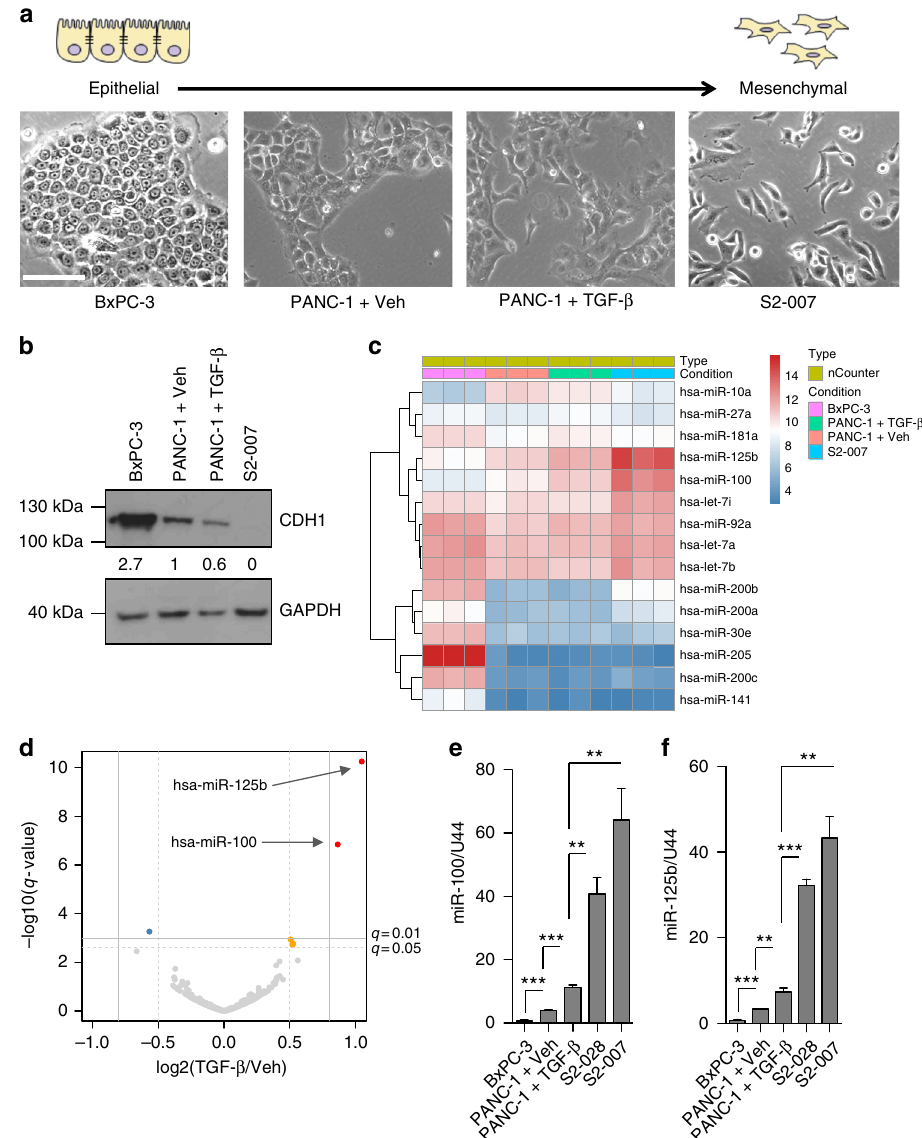
Fig. 1 miR-100 and miR-125b expression is associated with EMT in PDAC cells. a In vitro cell line model of EMT spectrum. Phase-contrast images show PDAC lines ordered from the most epithelial-like (left) to the most mesenchymal-like (right). Scale bar: 100 µ m. b Immunoblot for E-cadherin (CDH1) in PDAC cell lines with quanti fi cation of CDH1/GAPDH ratio. c Heatmap showing selected up and down-regulated miRNAs from the nCounter expression analysis. d Volcano plot displaying miR-100 and miR-125b being the most signi fi cantly up-regulated miRNAs upon TGF- β treatment. e , f RT-qPCR for miR- 100 in e and miR-125b in f in PDAC lines. Values were normalized to RNU44 levels and are shown as mean ± s.e.m. Results are from three independent experiments each performed in triplicate. ** P -value < 0.01, *** P -value < 0.001. P- values were calculated using two-tailed Student ’ s t